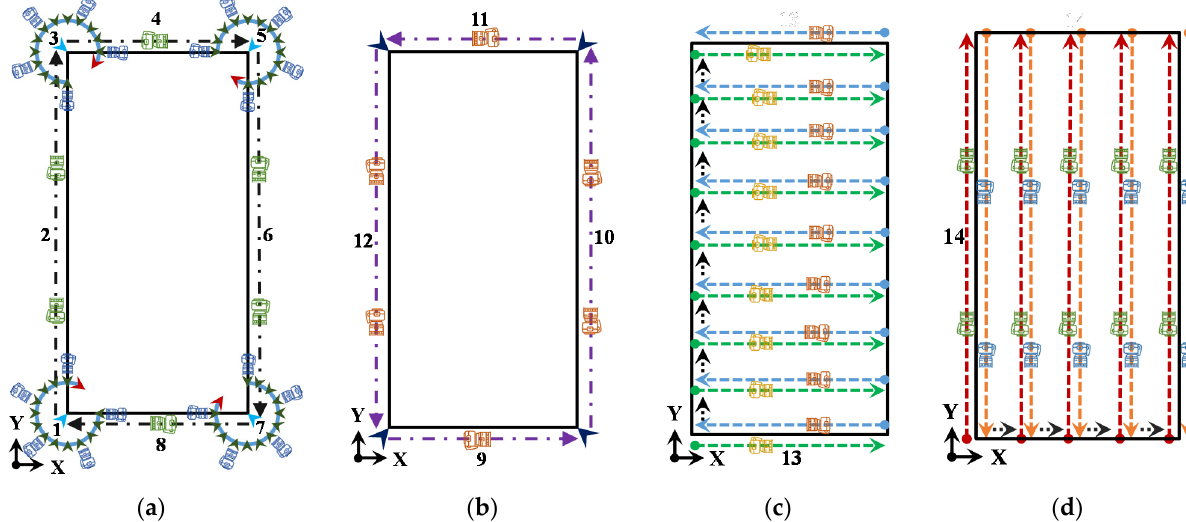
Figure 3. Diagram illustrates the camera movement to photograph the horizontal slab. ( a ) along corners and edges ( b ) opposite direction along the edges and the corners ( c ) shooting along the positive and negative X-axis and ( d ) along the positive and negative Y-axis.